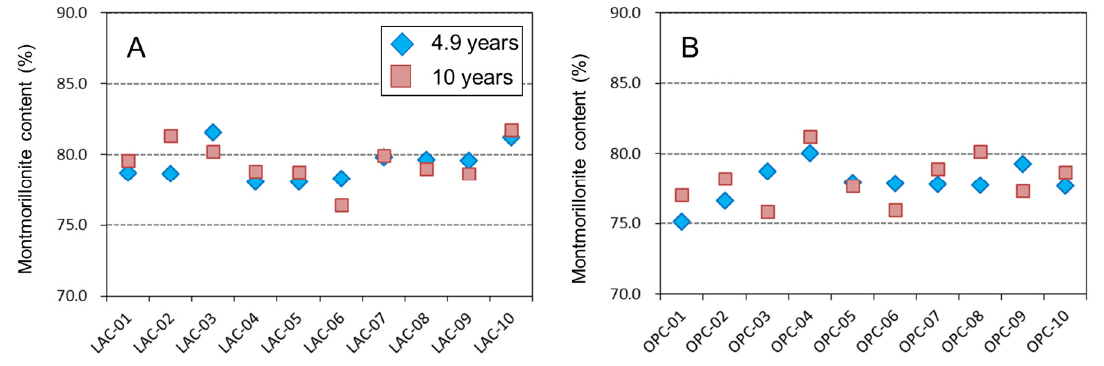
Figure 7. Montmorillonite content of bentonite. ( A ) LAC-MX and ( B ) OPC-MX for 4.9 (blue diamonds) and 10 (brown